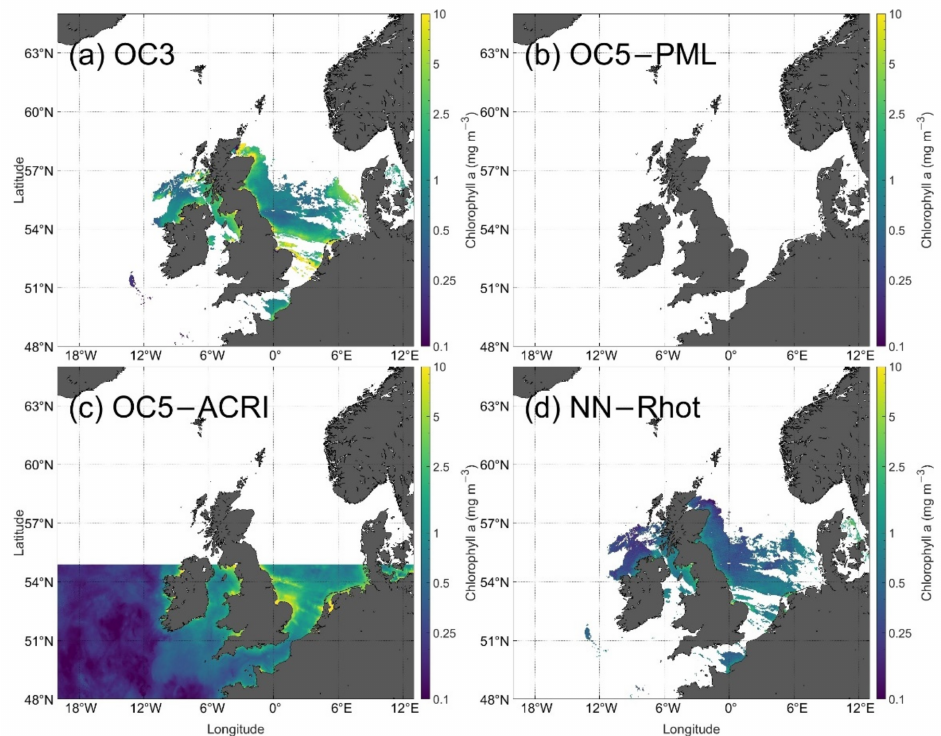
Figure 11. Chlorophyll a surface concentration for the 31 December 2019 from ( a ) OC3, ( b ) OC5-PML, ( c ) OC5-ACRI and ( d ) the median of 10 random neural networks using 3 layers of 15 neurons for the Rhot reflectance. Single MODIS-Aqua image at 13:05 for ( a , d ). Averaged daily image for ( b ). Daily image interpolated (+/ − 30 days) for ( c